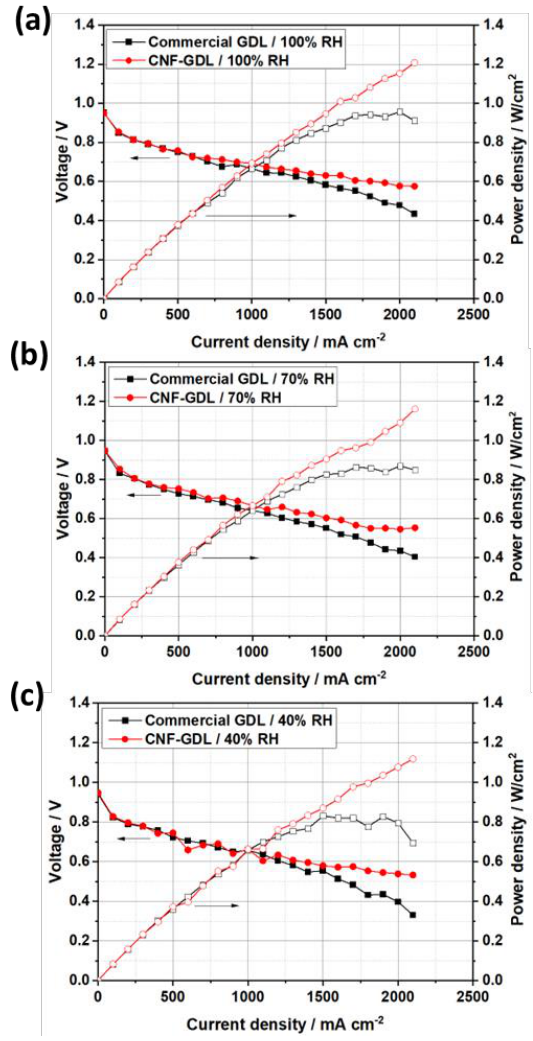
Figure 5. The single-cell performance of hydrophobic commercial carbon paper and CNF/carbon paper at different relative humidity conditions: ( a ) 100% RH, ( b ) 70% RH, ( c ) 40% RH.